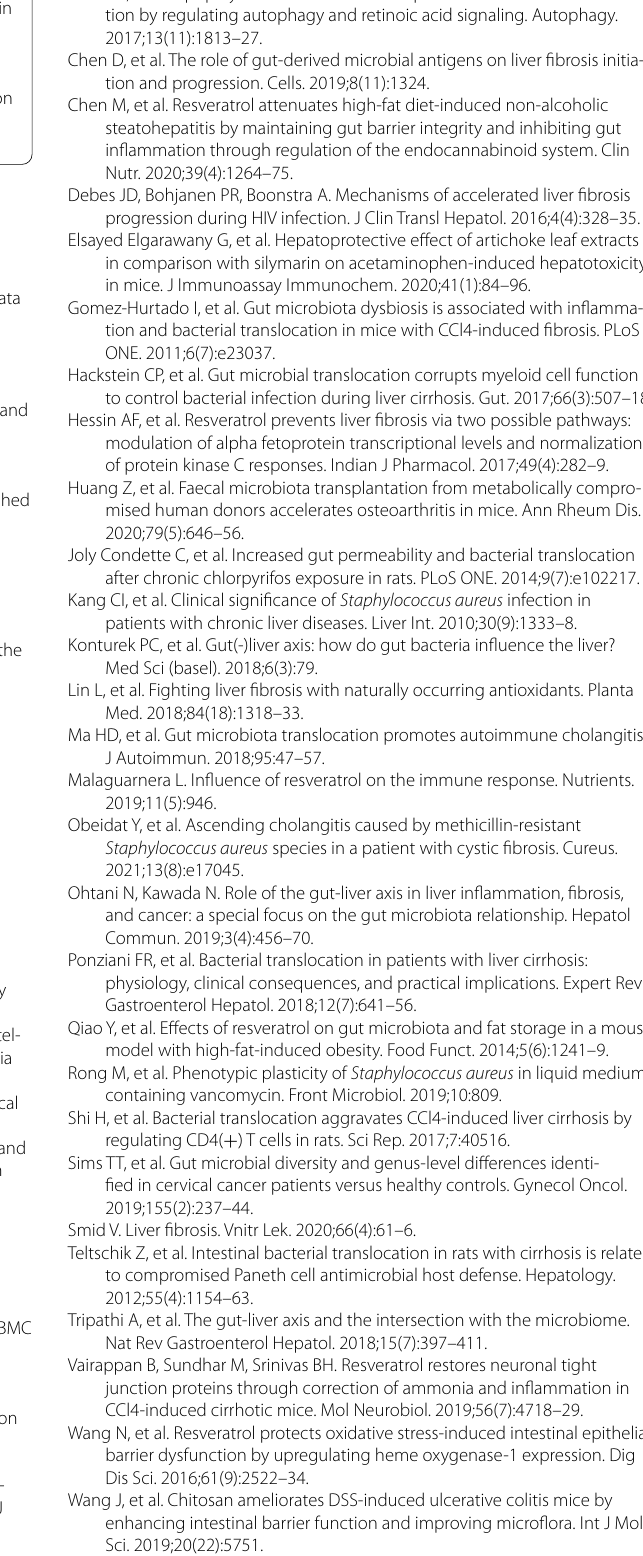
Additional file 5: Figure S5. A schematic representation for resveratrol in regulating liver fibrosis. The resveratrol treatment reduced the abun- dance of Staphylococcus_xylosus and Staphylococcus_lentus , which were crucial for the development of liver fibrosis. Staphylococcus_xylosus